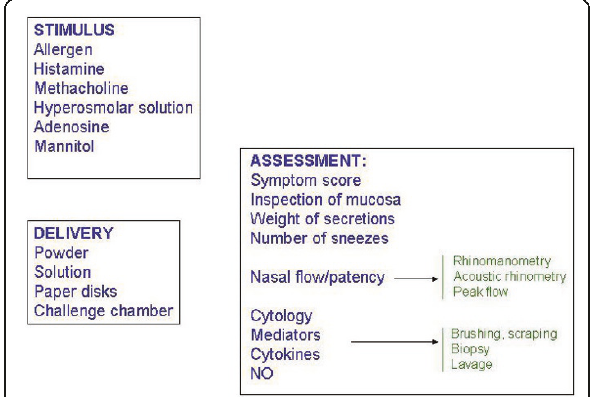
Figure 10 Practical approaches for nasal provocation test .